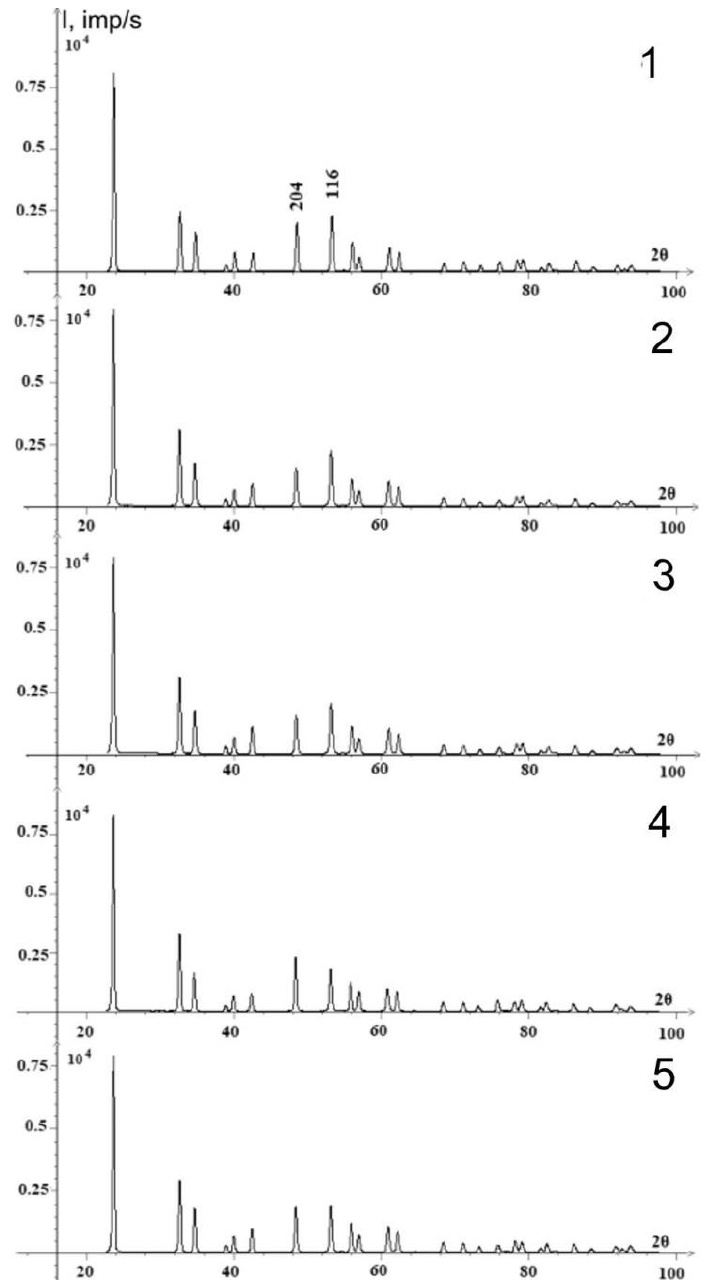
Figure 3. XRD patterns of powdered samples of NSLN1 ( 1 ); NSLN2 ( 2 ); CLN1 ( 3 ); CLN2 ( 4 ); and CLN3 ( 5 ).